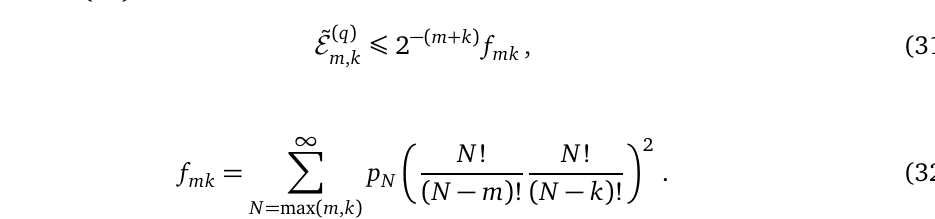
( k ) i + when (b): qubits